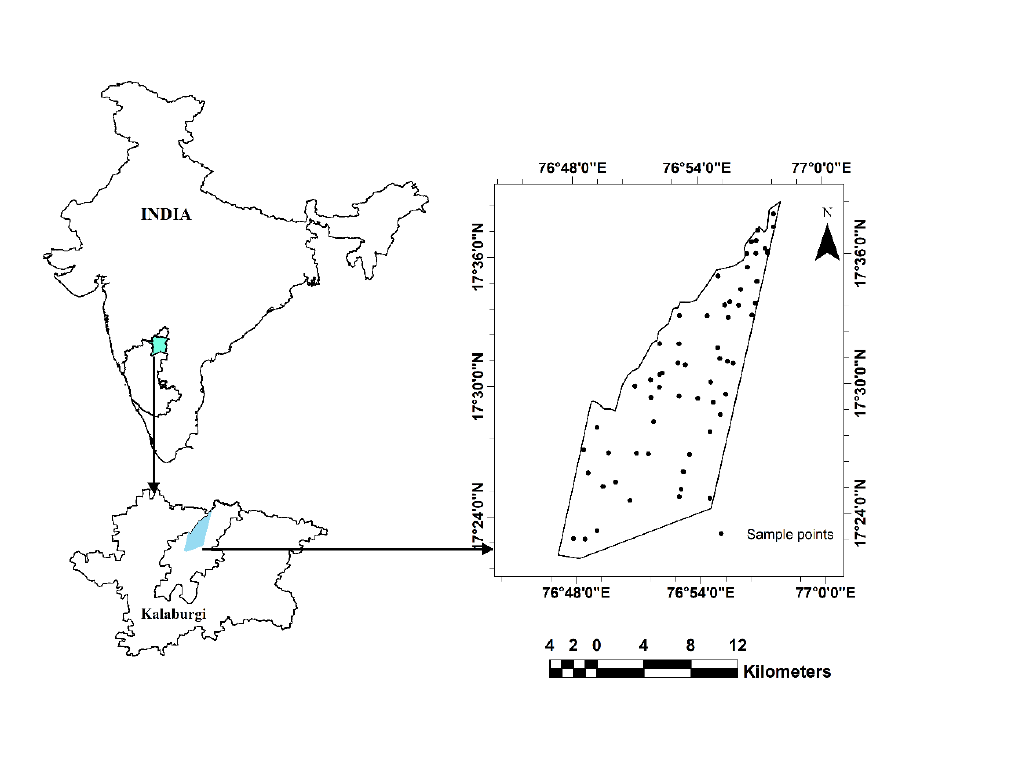
Figure 1. The location map of study area and sampling